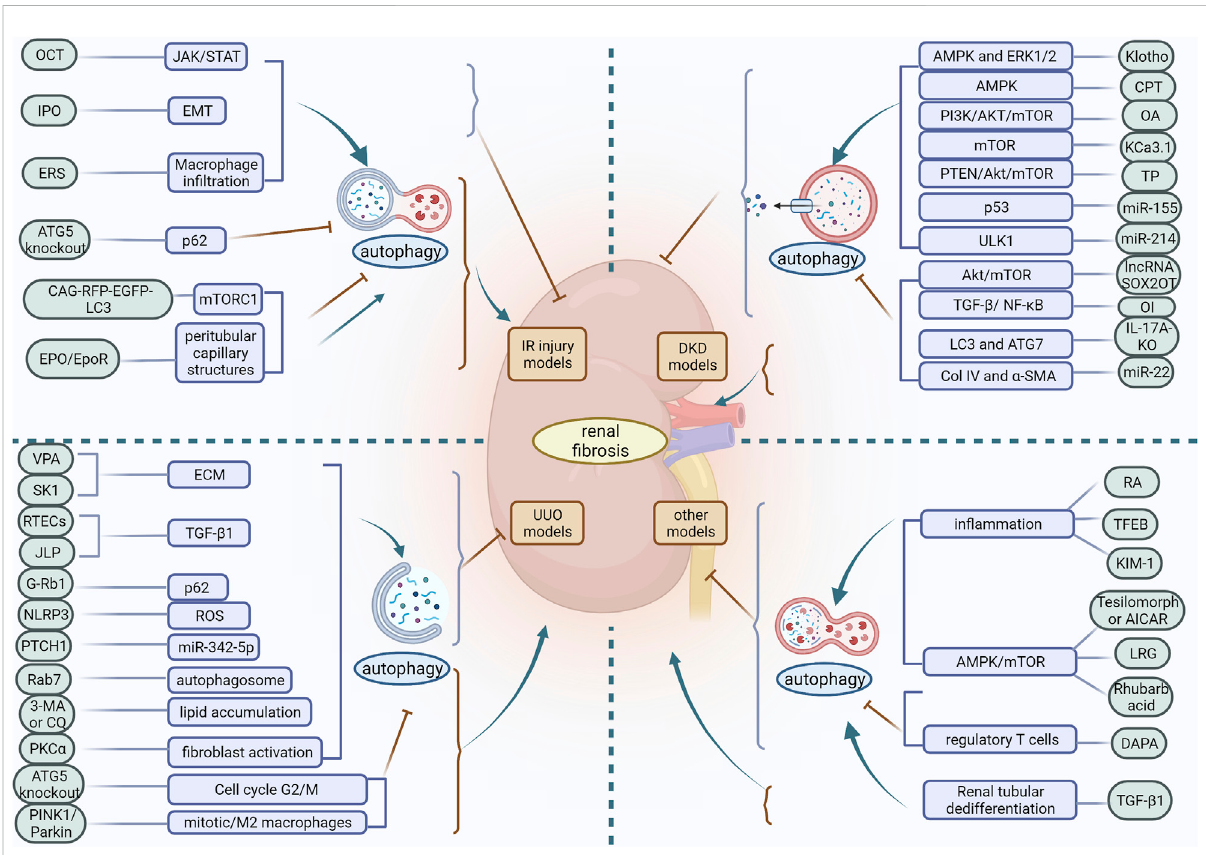
FIGURE 3 Indifferentexperimentalmodelsofrenal fi brosis,autophagyhasadualregulatoryrole.OCT,22-oxocalciferol;IPO,Ischemicpostconditioning; ERS, endoplasmic reticulum stress;VPA, Valproic acid; SK1, Sphingosine kinase 1; ECM,extracellularmatrix; RETCs, renal tubular epithelial cells; JLP, JNK-associatedleucinezipperprotein;ROS,reactiveoxygenspecies;PKC α ,proteinkinaseC α ;CPT,triterpenicacids-enrichedfractionfromCP;OA, oleanolic acid; TP, triptolide; OI, Itaconic acid 4-octyl ester; RA, retinoic acid; TFEB, transcription factor EB; KIM-1, Kidney injury molecule-1; LRG, liraglutide; DAPA,